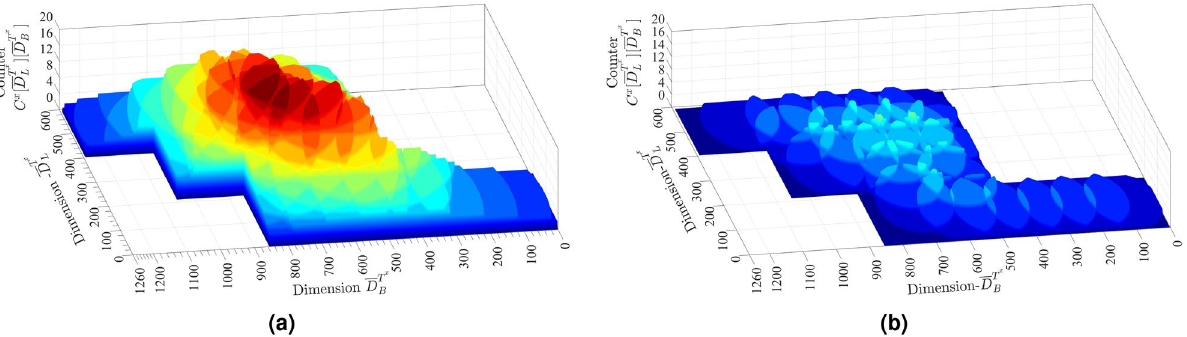
T x ][ D T x ] for x = wheat in ( a ) sowing and ( b ) maturity stage for NSGAII-NDS. MATLAB Figure 4. The C x [ D L B 2016a. https:// in. mathw orks. com/.